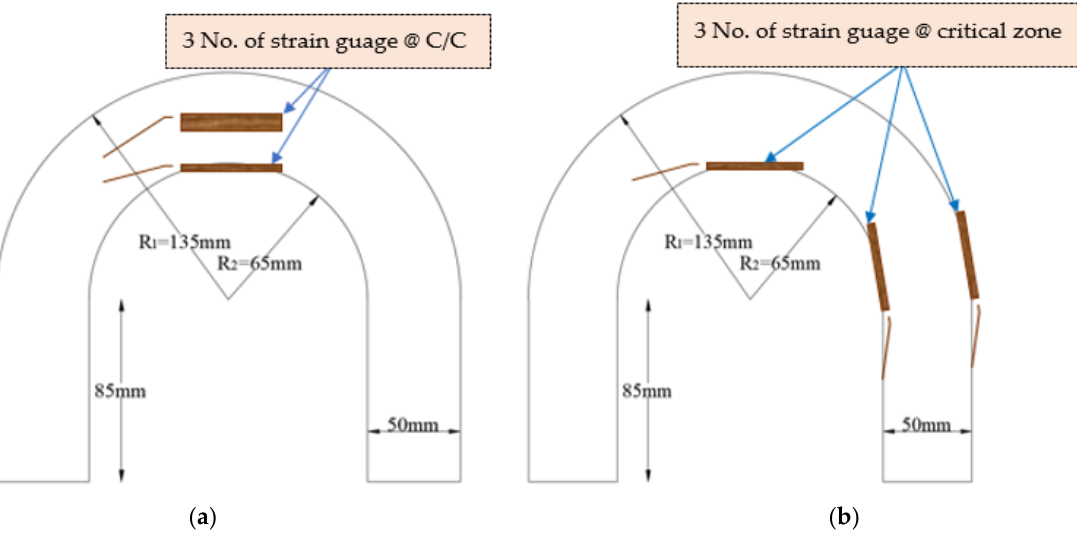
Figure 2. Dimension and instrumentation of the U-shaped specimen: ( a ) dynamic test and ( b ) static test.